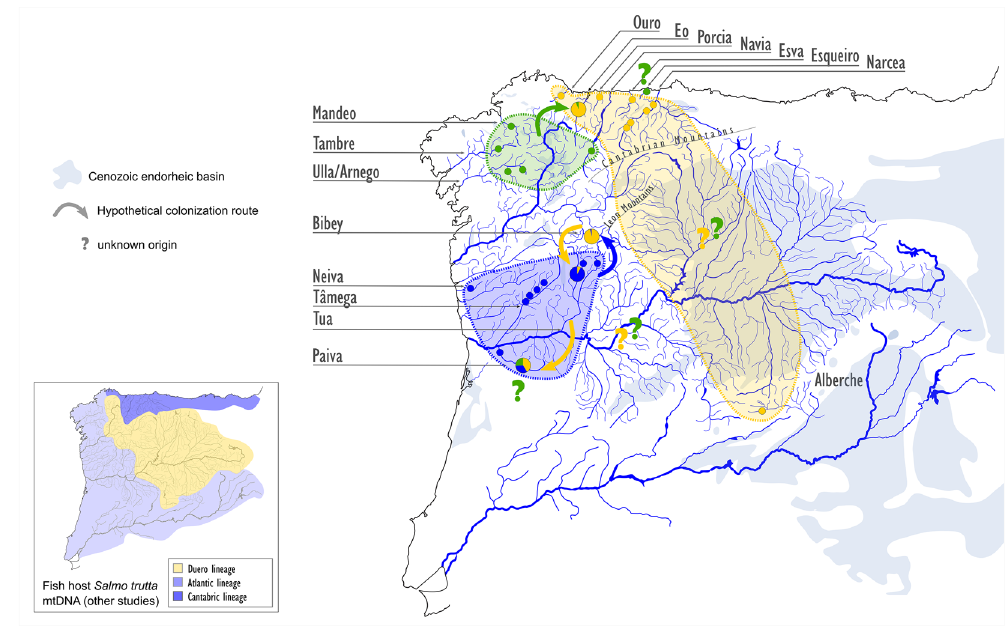
Figure 5. Hypothetical colonization routes of Margaritifera margaritifera in the Iberian Peninsula in relation to genetic population structure of its host Salmo trutta (lower left